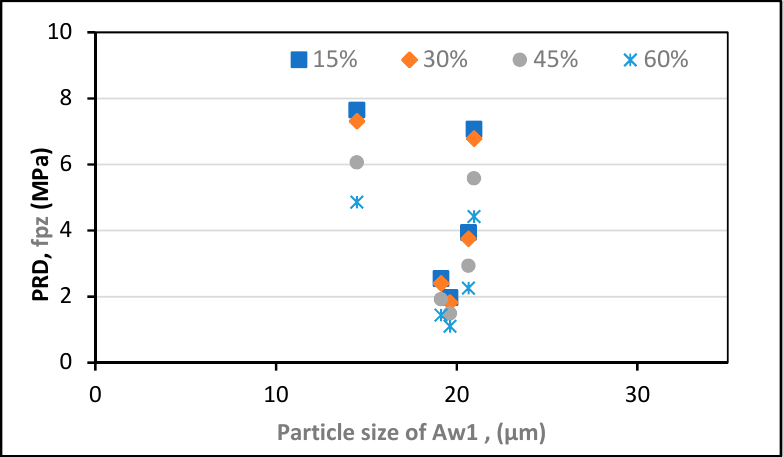
Figure 5. Discrepancy trends of the pozzolanic part with the particle diameter at varying percent- ages.